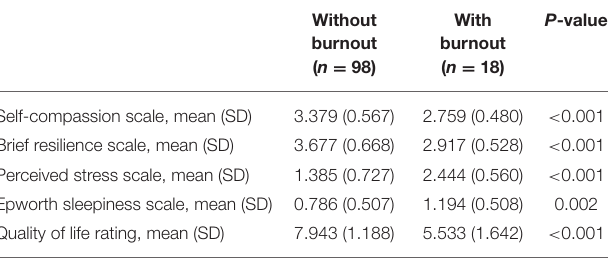
TABLE 3 | Association of burnout with personal characteristics. TABLE 4 | Faculty and fellow attitudes, job satisfaction, and